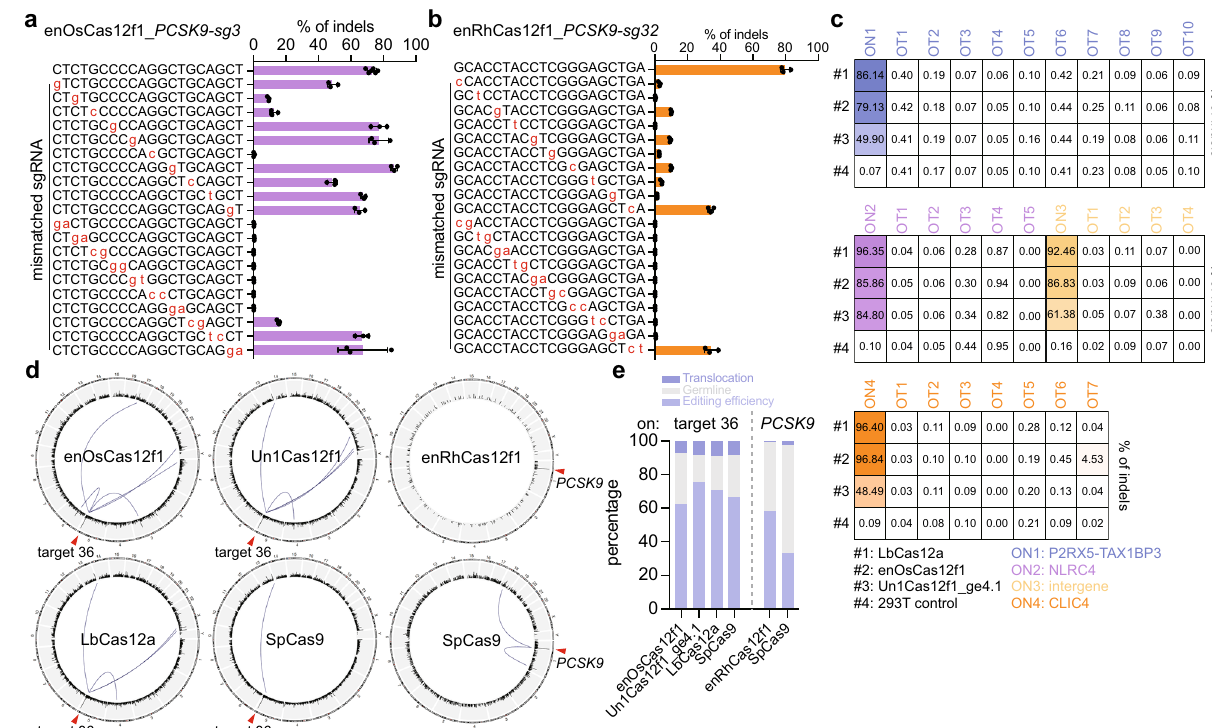
Fig.5|Speci fi citiesofenOsCas12f1-andenRhCas12f1-mediatedgenomeediting in human cells. a Effects of mismatched sgRNA with 1bp or 2bp on activities of enOsCas12f1 at PCSK9 locus. Values and error bars represent mean and s.d. ( n =3). b Mismatch tolerance of enRhCas12f1 at PCSK9-sg32 . Values and error bars repre- sent mean and s.d. ( n =3). c Off-target ef fi ciency of LbCas12a, enOsCas12f1, and Un1Cas12f1_ge4.1atinsilicopredictedoff-targetsites,determinedbytargeteddeep